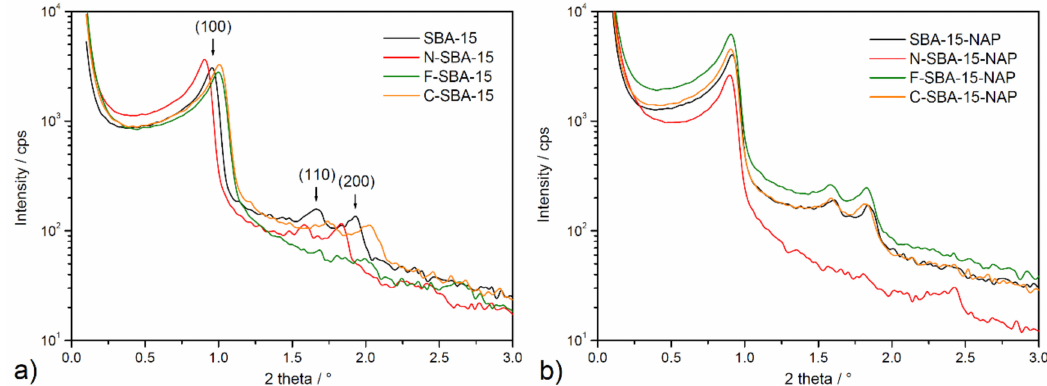
Figure 6. SAXS patterns of ( a ) modified and unmodified materials SBA-15, N-SBA-15, C-SBA-15, F-SBA-15, and ( b ) samples after naproxen loading SBA-15-NAP, N-SBA-15-NAP, C-SBA-15-NAP,